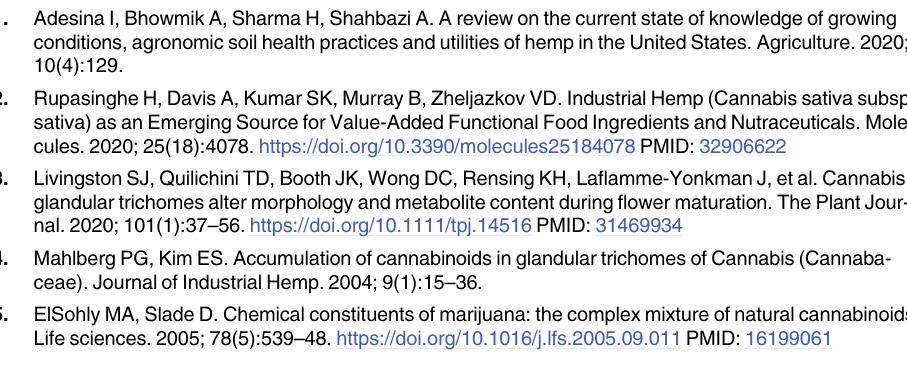
above the EC threshold. Percentages in parentheses indicated the percent reduction of the W trait relative to the 50 ppm N fertilizer treatment (EC =